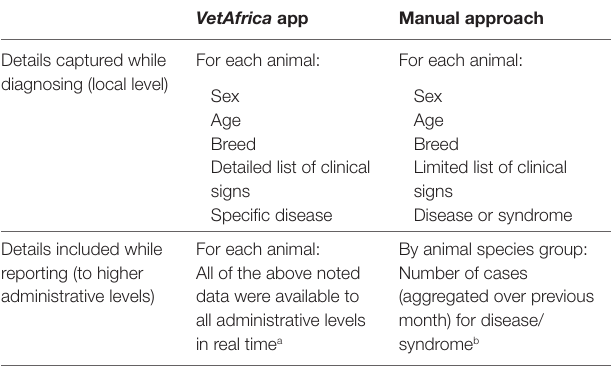
TaBle 3 | Summary of main non-specific diagnoses given for cases diagnosed in cattle using the traditional paper-based approach. Diagnosis/syndrome